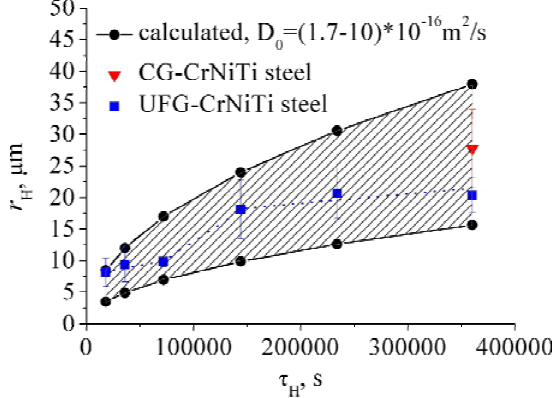
Fig. 16. Comparison of the values r drogen-affected surface layer, estimated using D 2  -criterion and from the observation of frac- 0 H ture surfaces of CG-CrNiTi and UFG-CrNiTi speci-